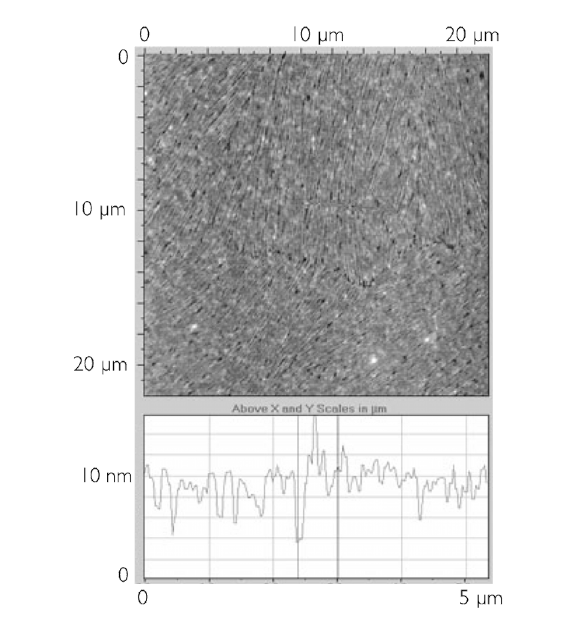
fibers aggregating into superstructures.